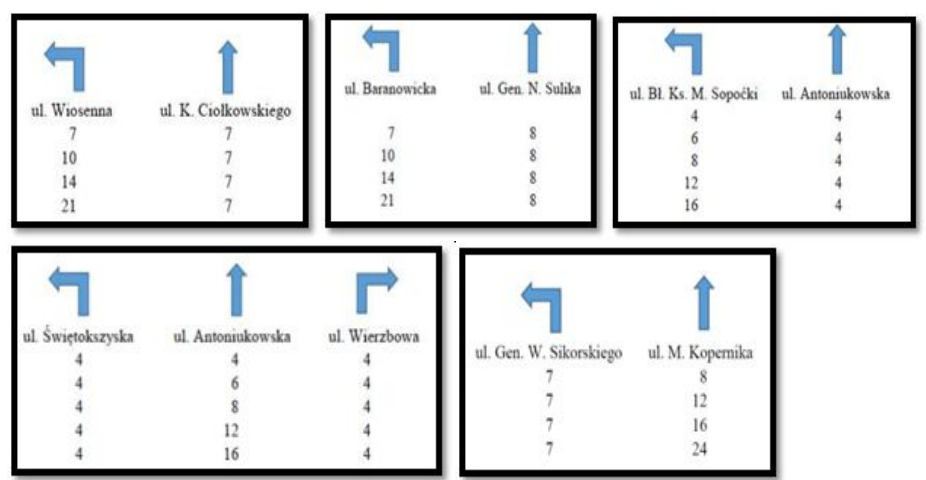
Figure 3. Simulated travel times displayed on the VMSs.